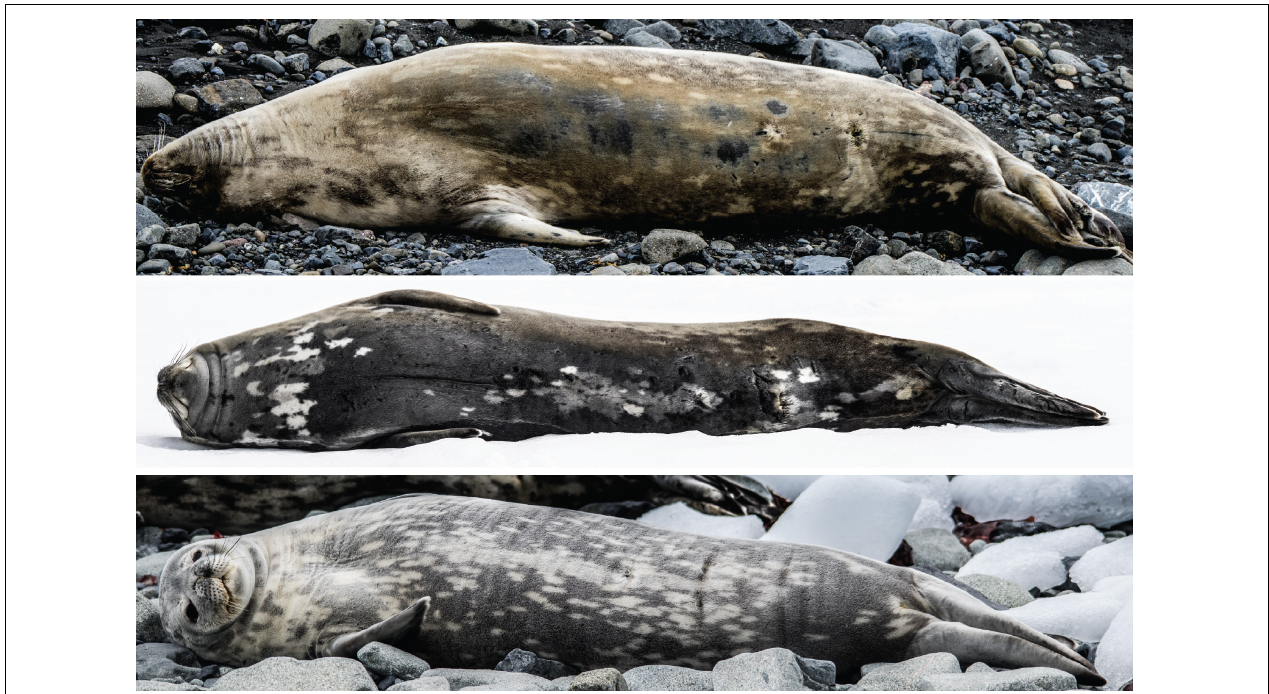
FIGURE 3 | (A) A pre-molt individual showing heavy wear on the ventral surface. (B) A seal mid-molt. (C) A recently-molted